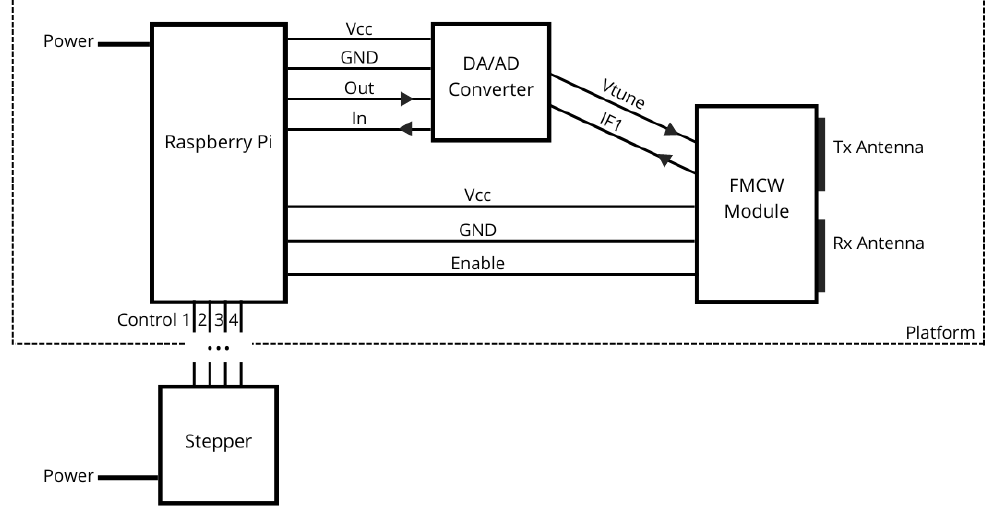
Figure 3. GBSAR-Pi